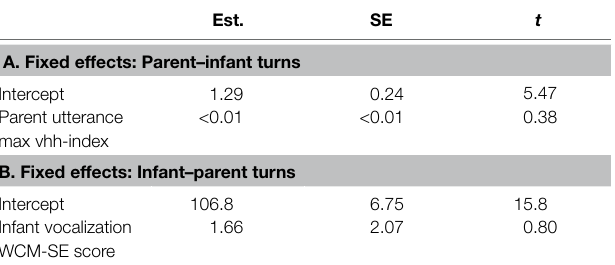
TABLE 5 | Summary of the fixed effects of the analysis of the measure max vhh-index in parent–infant turns (A) and infant–parent turns (B). No significant effects were found.